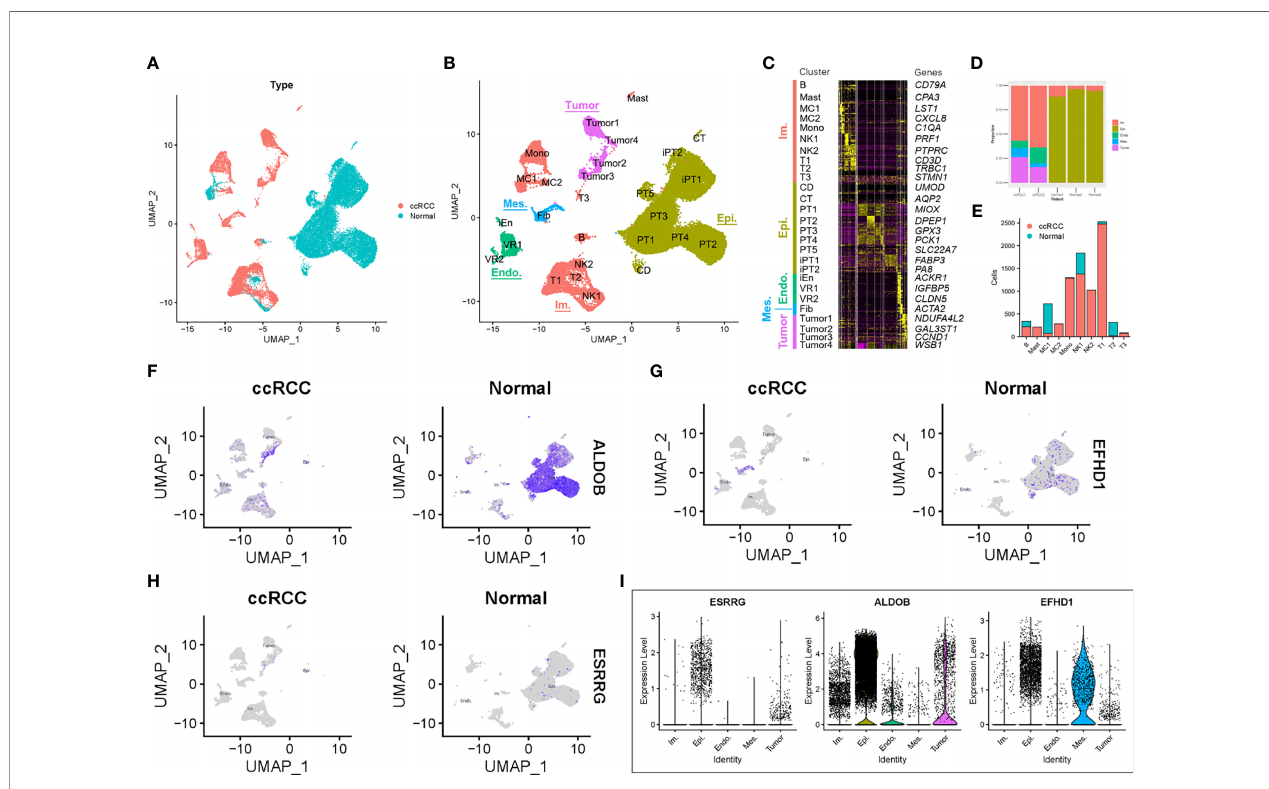
FIGURE 7 | Prognostic expression pro fi le based on single-cell sequencing analysis. (A) Composition and distribution of single cells from GSE131685 and GSE171306. (B) UMAP embedding of 34,371 single cells from three human normal kidneys and two ccRCC samples. Labels refer to 27 clusters identi fi ed. (C) Scaled gene expression of the top 10 speci fi c genes in each cluster. Each column is the average expression of all cells in a cluster. (D) Composition of different cell types in the fi ve single-cell RNA-seq samples. (E) Number of cells per immune cell type and clinical parameter. The expression pro fi le of (F) ALDOB , (G) EFHD1 , and (H) ESRRG for each cell and the (I) violin plot. UMAP, Uniform Manifold Approximation and Projection; ccRCC, clear cell renal cell carcinoma; Im., immune; Epi., epithelial; Endo., endothelial; Mes, mesenchymal; CD, collecting duct; CT, connecting tubule; iEn, injured endothelial cells; Fib, fi broblast; Mast, mast cell; MC, macrophage; Mono, monocyte; PT, proximal tubule; iPT, injured proximal tubule; VR, vasa